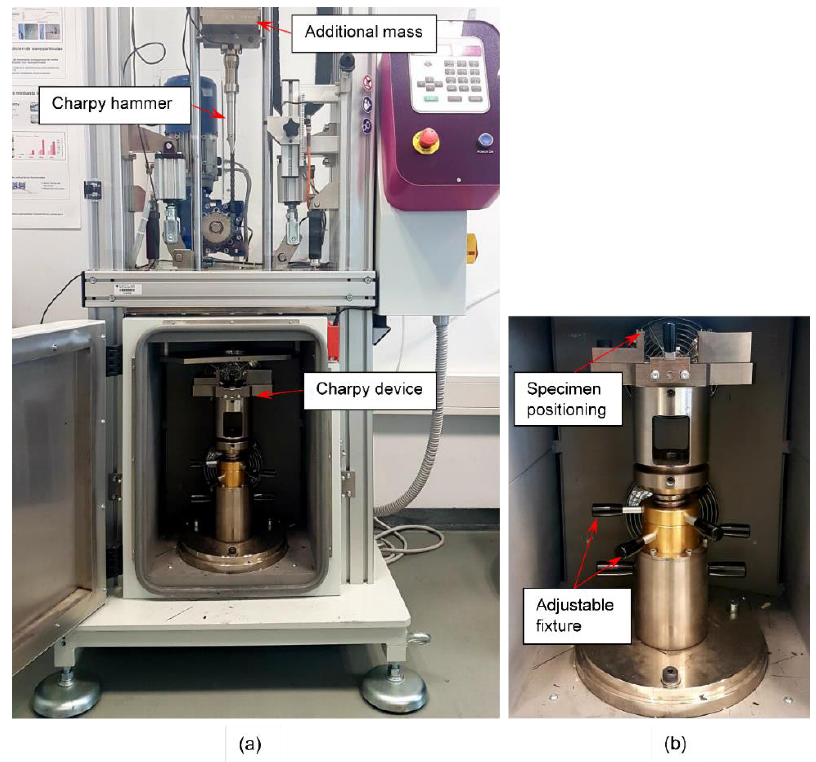
Figure 2. Experimental set-up for drop-weight impact test. ( a ) Drop-weight column device and ( b ) Charpy support fixture according to ASTM D6110.